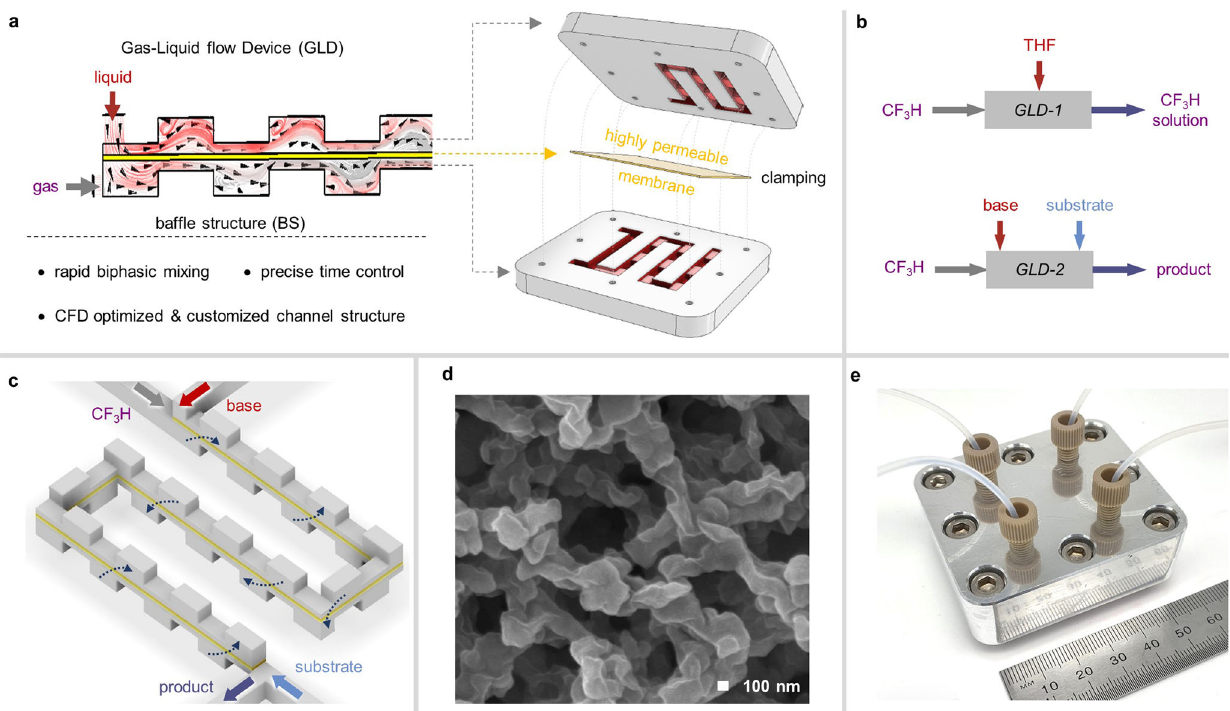
Fig. 2 | Design, CFD-based optimization, and fabrication of gas-liquid fl ow device (GLD) including highly permeable membrane and staggered baf fl e channel.a A schematicconcept and fabrication of gas-liquid fl ow device